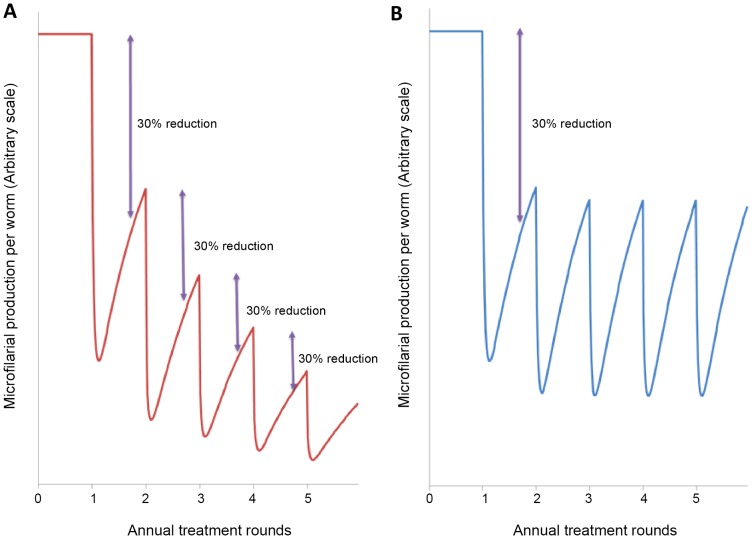
Schematic representation of two different proposed effects of ivermectin on Onchocerca volvulus microfilarial production.The schematic represents a closed population of adult worms (i.e., no incoming worms due to transmission or worm death). A: Ivermectin is assumed to have a cumulative effect on adult worm fertility by which the microfilarial production of ivermectin-exposed adult worms is reduced by 30% after each treatment round (red solid line). B: Ivermectin is assumed not to have a cumulative effect; ivermectin-exposed adult worms resume microfilarial production to 70% of its baseline value ten months after each treatment [17] (blue solid line).